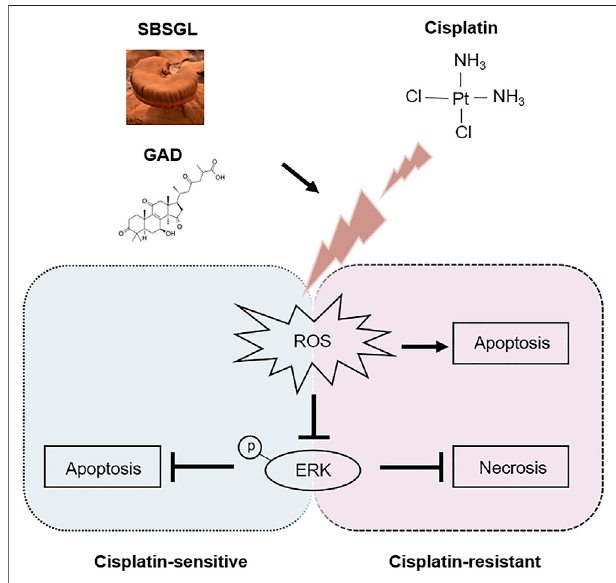
FIGURE 6 | The underlying mechanism involved in the chemo- sensitization effect of SBSGL/GAD on ovarian cancer.